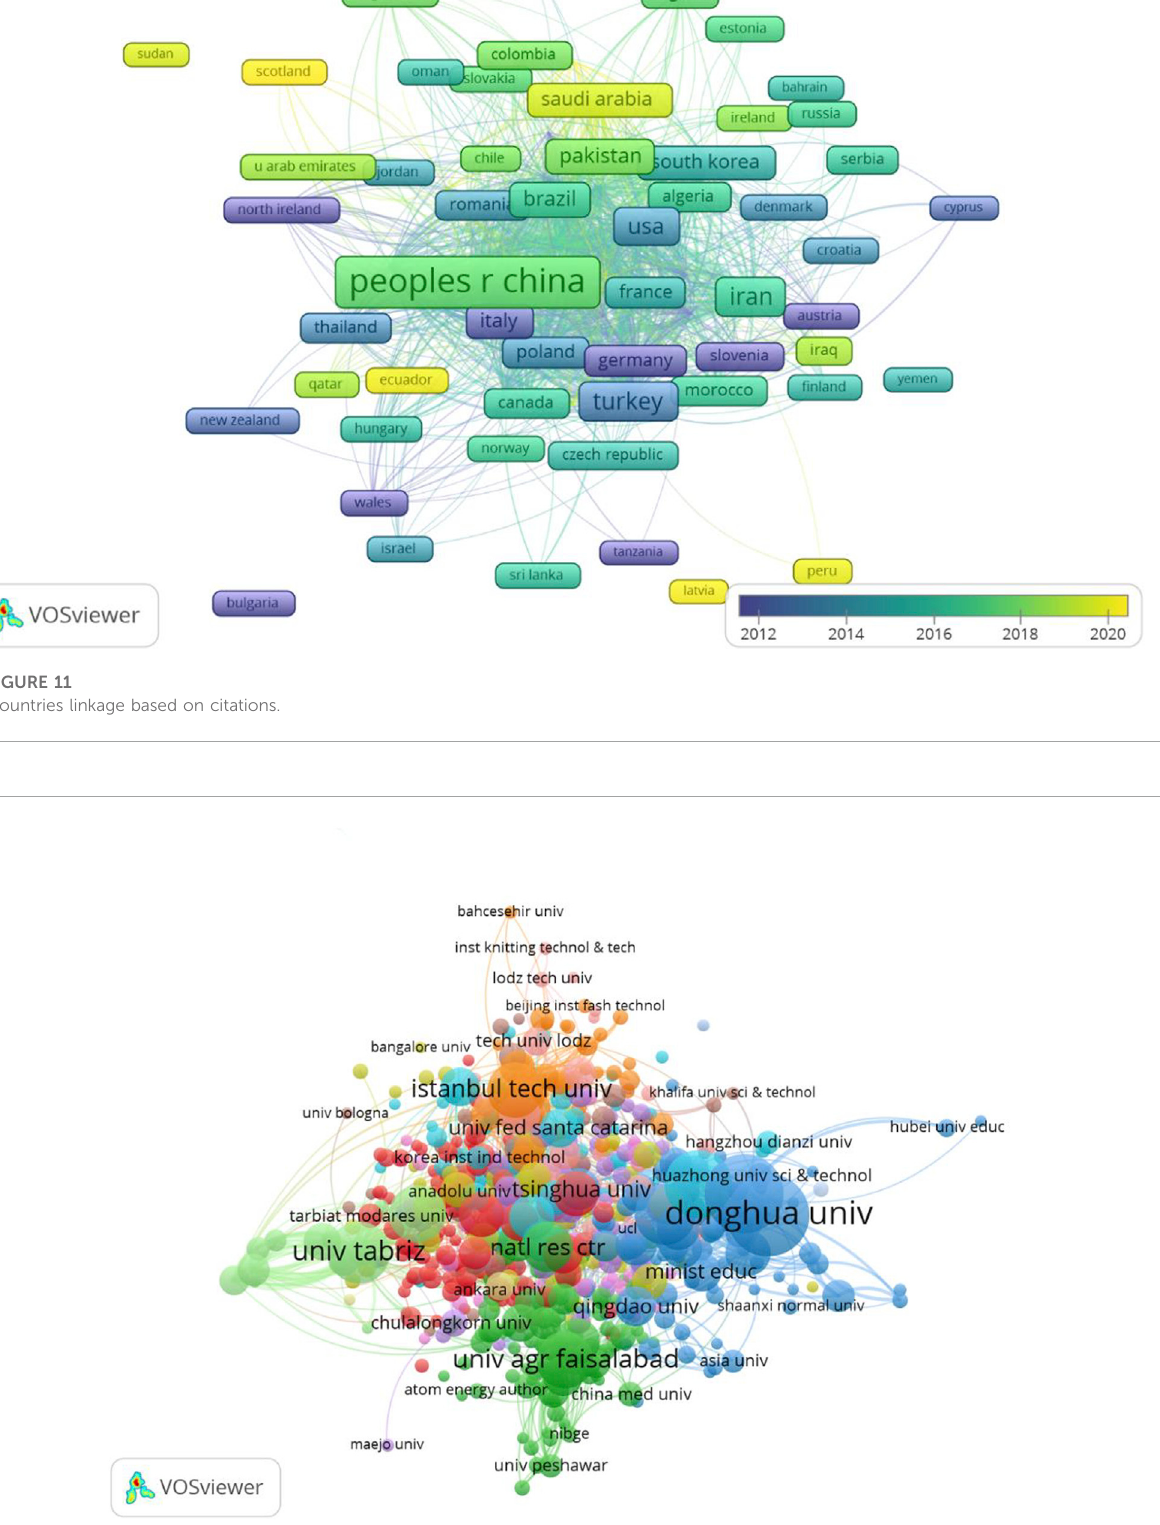
Frontiers in Environmental